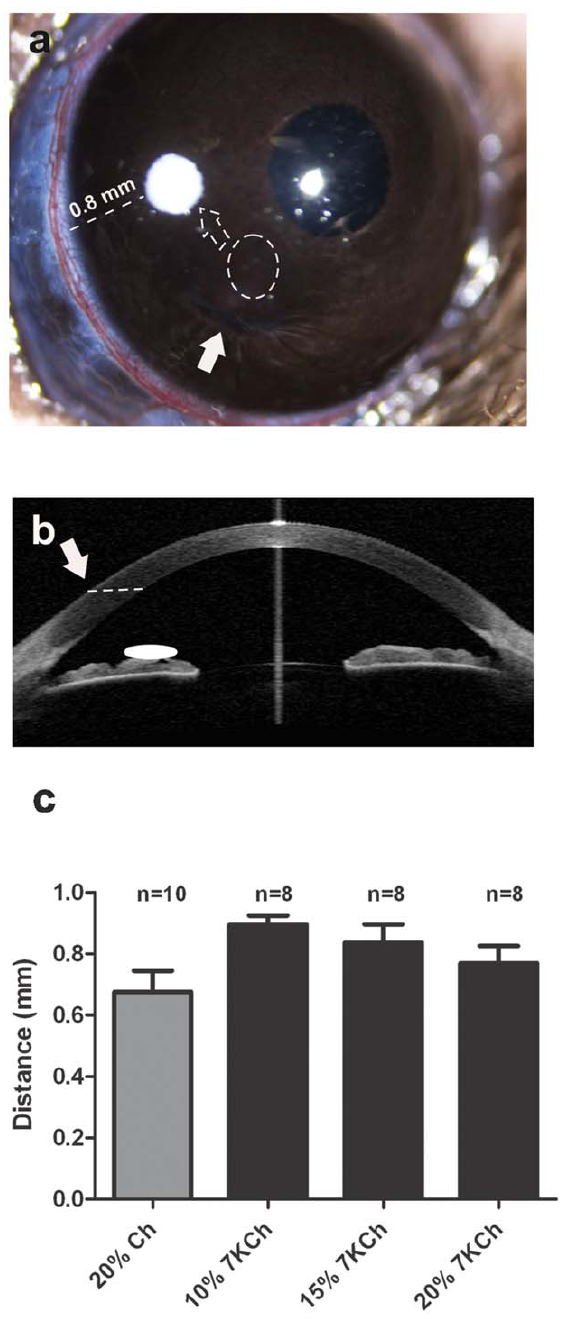
Figure 1. Wafer implantation into the rat anterior chamber. A. A full thickness corneal incision was made parallel to the plane of the iris (arrows). Wafers were introduced to the anterior chamber using toothless forceps (dotted circle), and displaced to its temporal position (dotted arrow) in the anterior chamber. B. Side-view schematic showing the approximate location of the implant. C. The final position of all implants was an average of 0.8 mm from the limbus (dotted line). Ch=cholesterol, 7KCh=7-ketocholesterol, n=number of wafers im- plants.